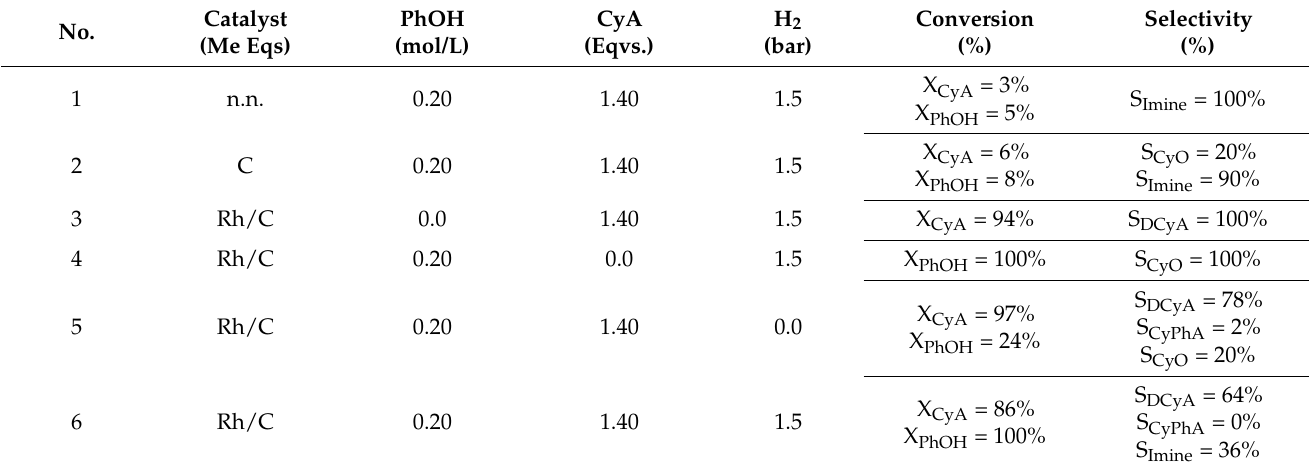
Table 2. Control experiments for the amination of phenol (PhOH) with cyclohexylamine (CyA)